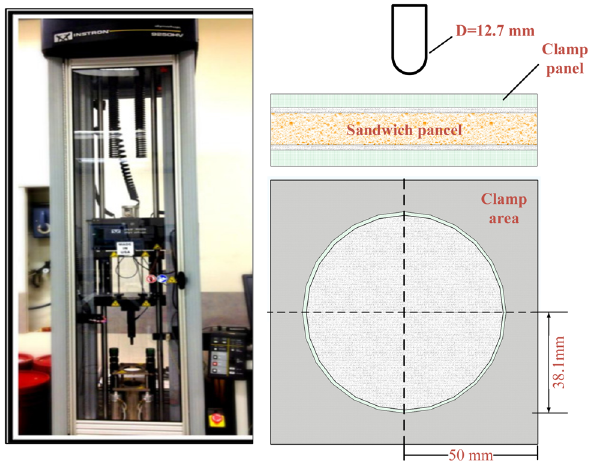
Figure 3: INSTRON 9250HV impact testing machine.